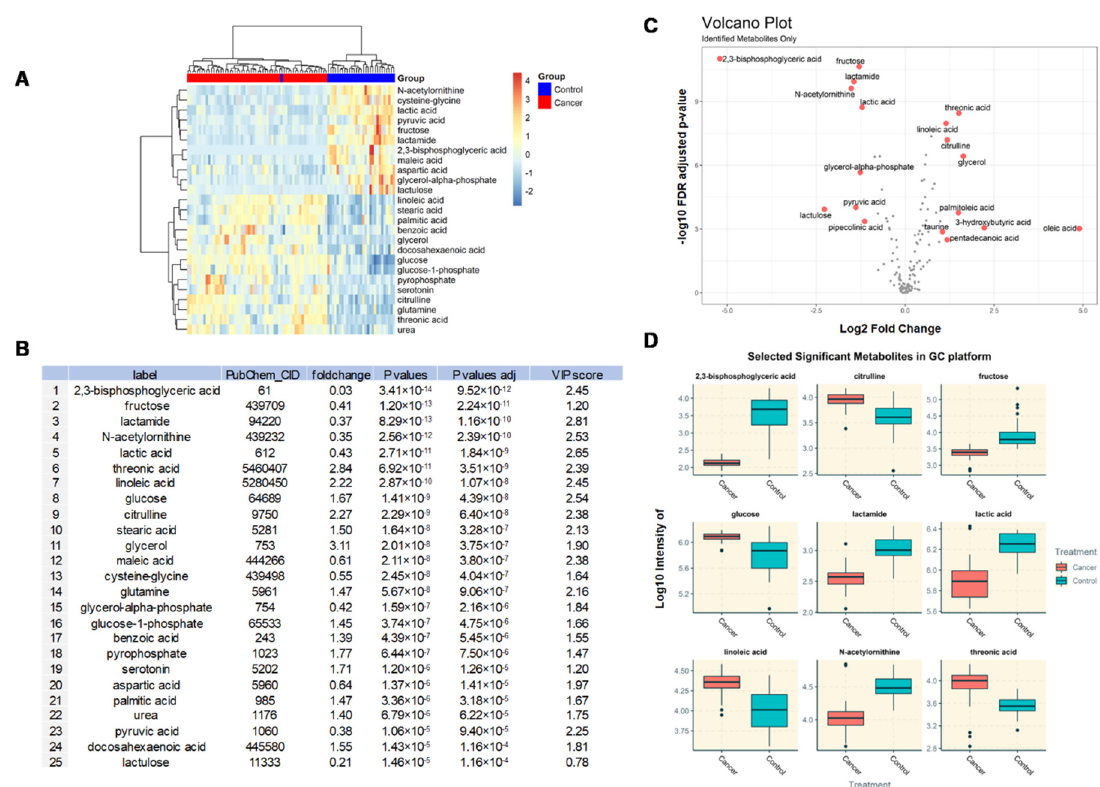
Figure 2. ( A ) Heatmap of identified metabolites in the GC platform showing the 25 differentially expressed metabolites (DEMs) between BC and control groups with the smallest Mann-Whitney U test p -values. Euclidean distance metric and Ward’s clustering method was used for the hierarchical clustering of samples and compounds. ( B ) A table summarizing the 25 identified metabolites and their statistical values. Fold-changes are presented as median average of cancer divided by control. False discovery rate-adjusted p -values using the Benjamini–Hochberg procedure are reported at the last column. VIP score for each compound is reported in Figure 3B (VIP > 1 highlighted as red). ( C ) Volcano plot with annotated metabolites that were significantly altered in BC patients compared to controls. The red dots represent metabolites above the threshold. The further the metabolite’s position away from the (0, 0), the more significant the metabolite is. Volcano plot visualizes the –log10 adjusted p -values and log2 fold-changes. Metabolites with adjusted p -values less than 0.05 and a fold-change greater than 2-fold or less than ½-fold are highlighted and labeled. ( D ) Selected boxplots of metabolites showing the most significant changes in the GC platform.